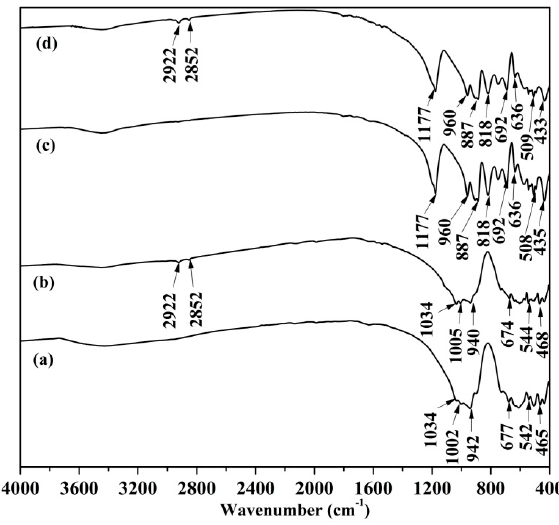
Figure 6. The infrared spectra of kyanite ( a ), kyanite treated with sodium oleate ( b ), sillimanite ( c ) and sillimanite treated with sodium oleate ( d ).